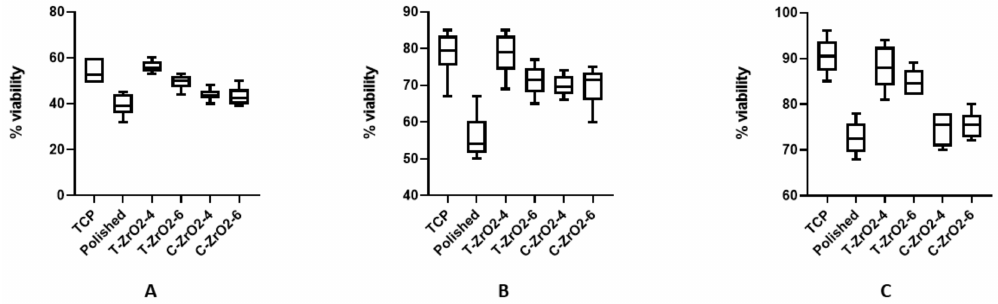
Figure 5. Cell viability assay of human osteoblasts on different surfaces on day 1 ( A ), 3 ( B ) and 7 ( C ); N =